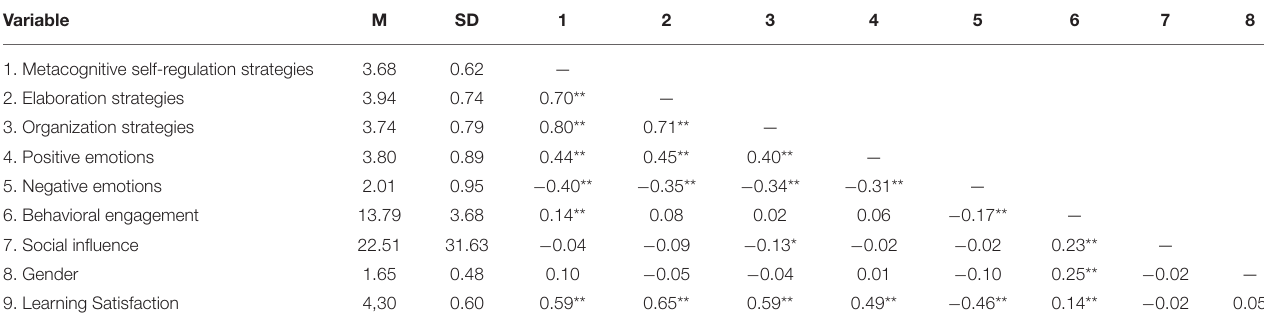
TABLE 2 | Descriptive statistics and correlation analysis of each variable. Variable